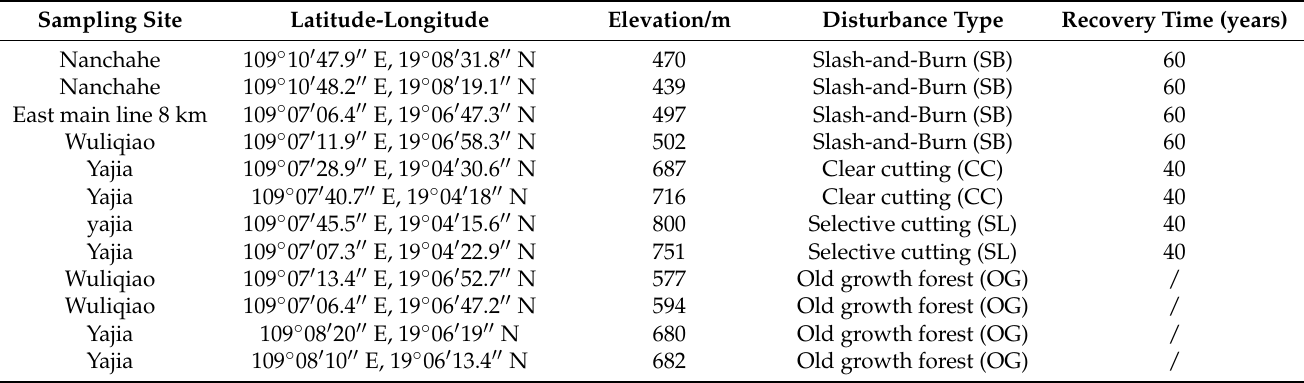
Table A1. Descriptions about community sample plots in the four forest